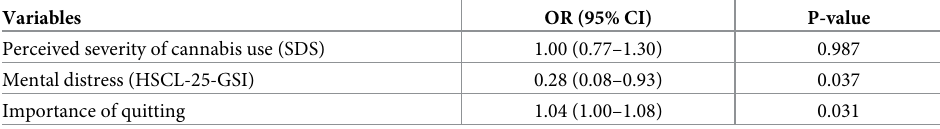
Table 5. Multivariable logistic regression results show associations between post-treatment cannabis abstinence (T1) and baseline